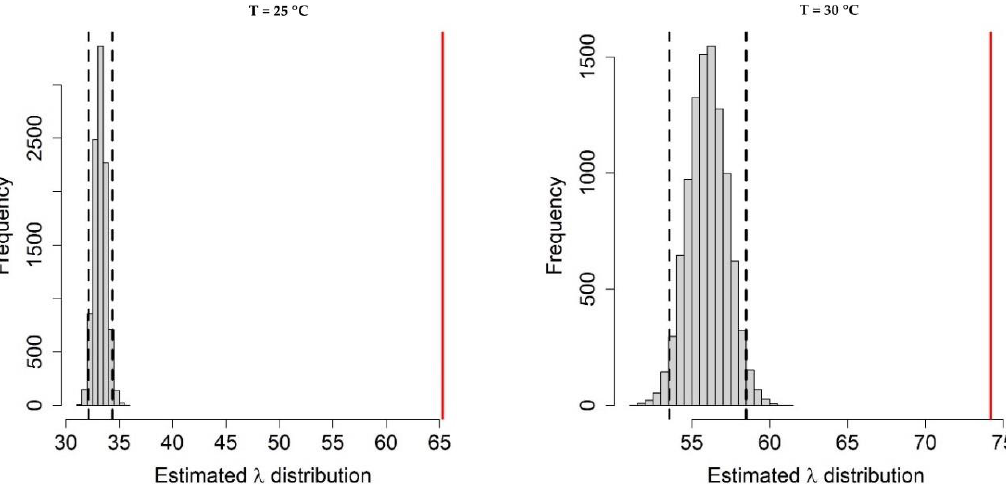
Figure A8. Estimated posterior distributions of Λ NE (T), the number of eggs laid on average by a female mosquito at 25 and 30 °C for each gonotrophic cycle. Dashed black lines represent the 2.5 and 97.5 quantiles. Solid red lines represent the average value for subtropical Ae. albopictus .